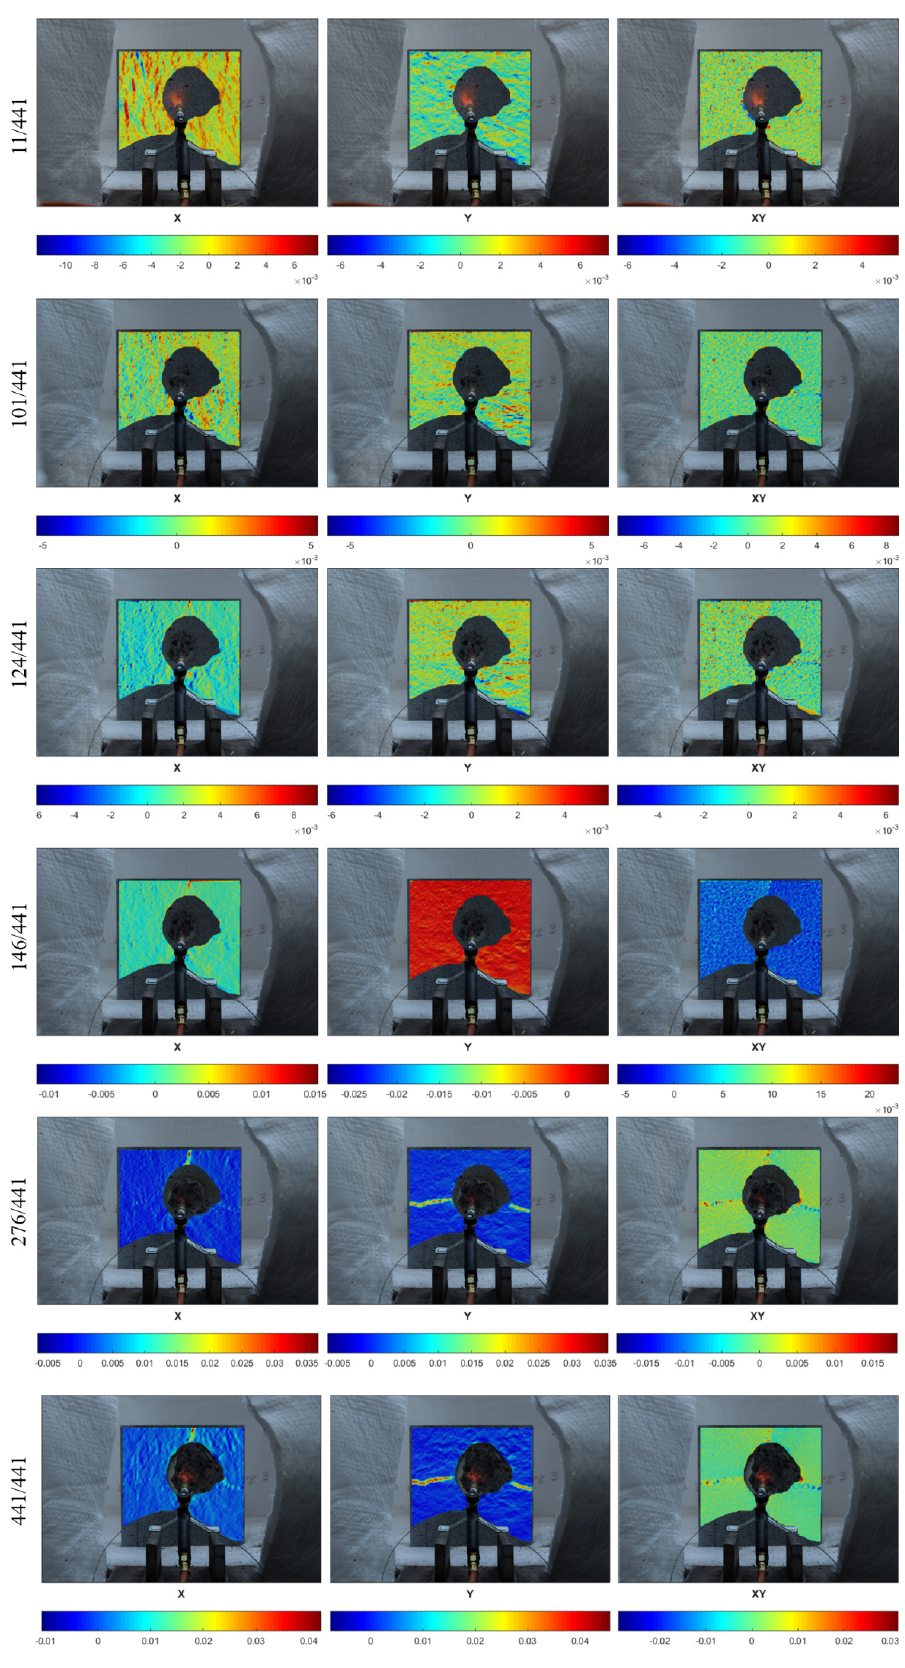
Figure 9. Deformation fields in the x- and y-directions for the largest specimen (300 × 300 mm).